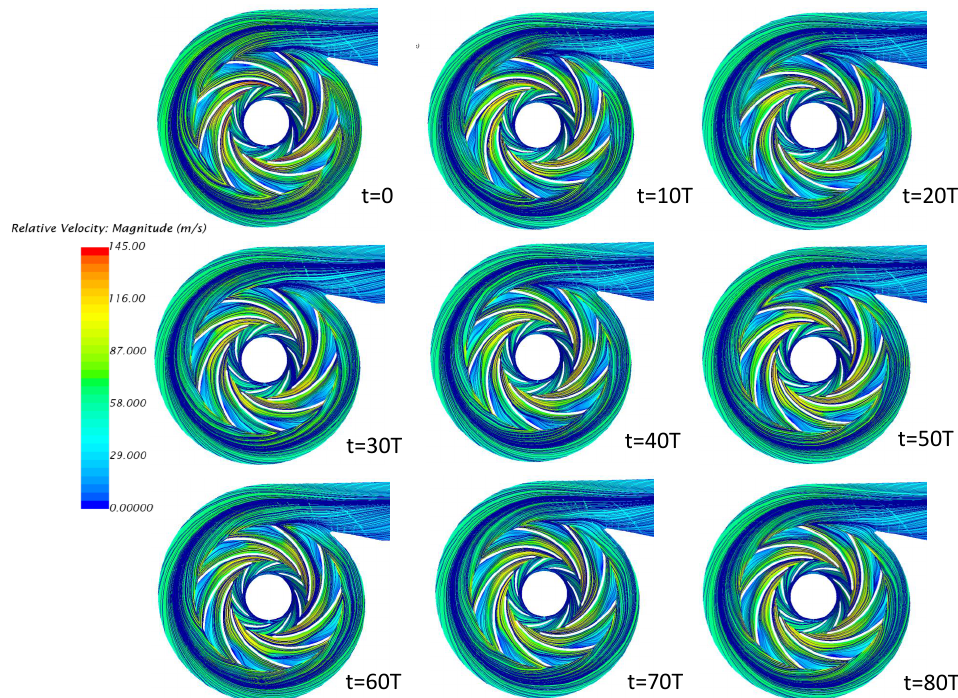
Figure 12. Streamline patterns of different time-step at